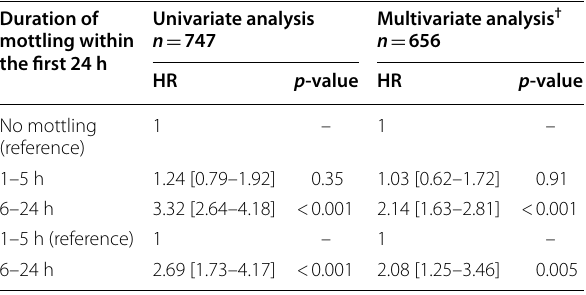
Table 2 Univariate and multivariate analysis evaluating the impact of the course of mottling on day 90 mortality in septic